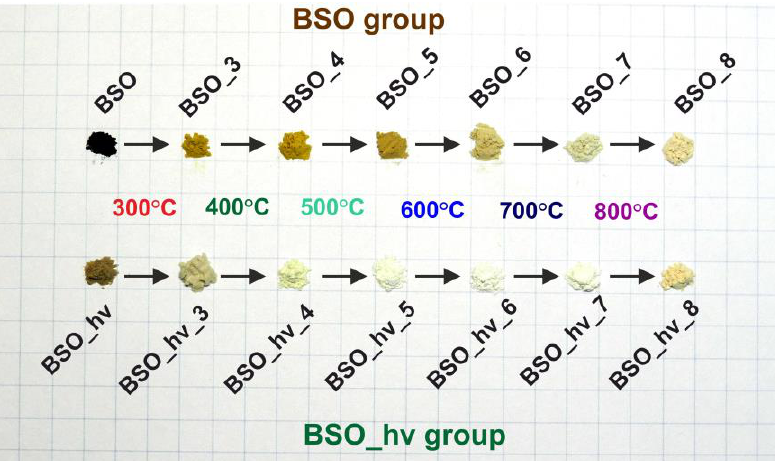
Figure 1. Photographs of initial and annealed powders studied. Images for samples annealed at 200 °C are not presented, as they did not differ from initial